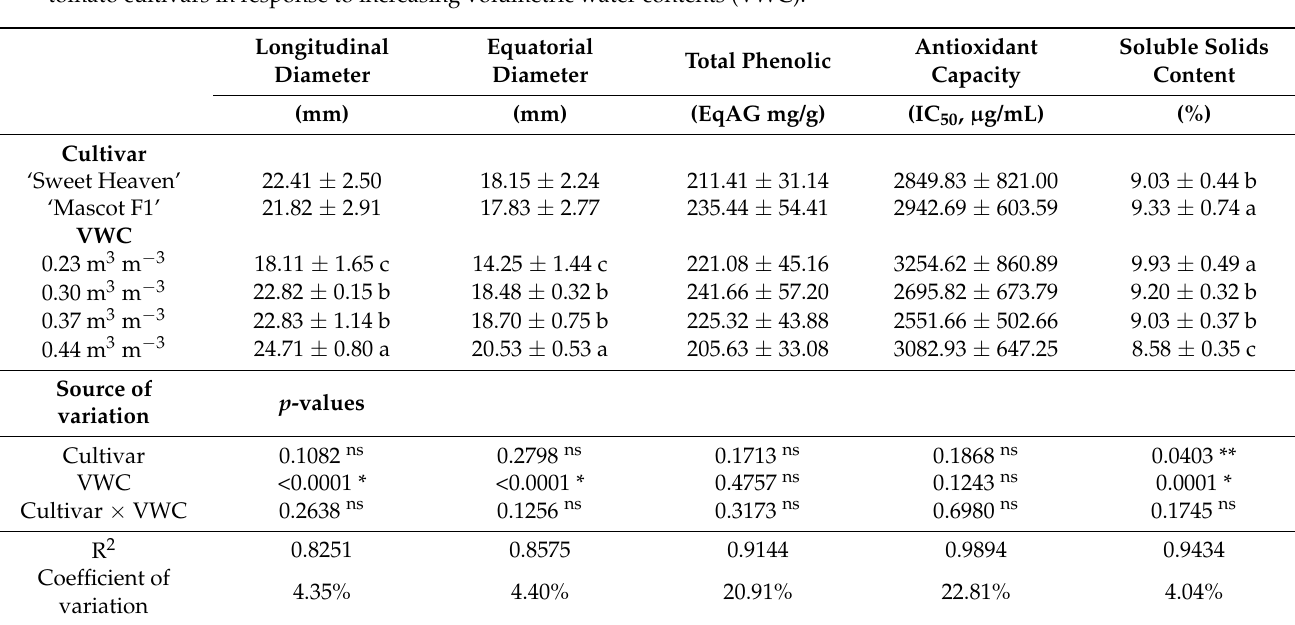
Table 2. Longitudinal and equatorial diameter, total phenolic, antioxidant capacity, and soluble solids content of two cherry tomato cultivars in response to increasing volumetric water contents (VWC).